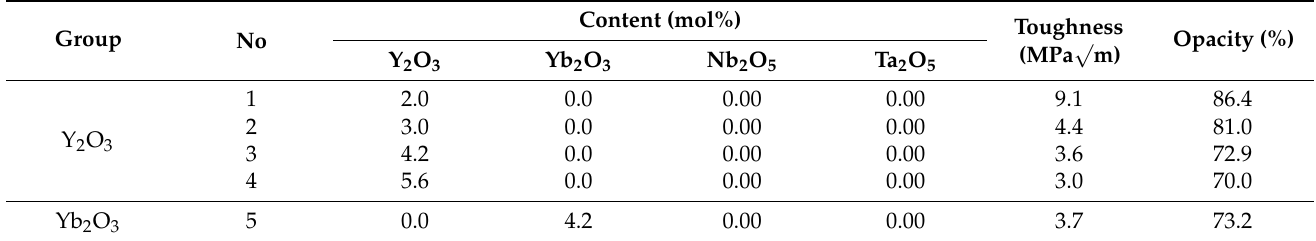
Table 1. Chemical composition of stabilizers and their fracture toughness and